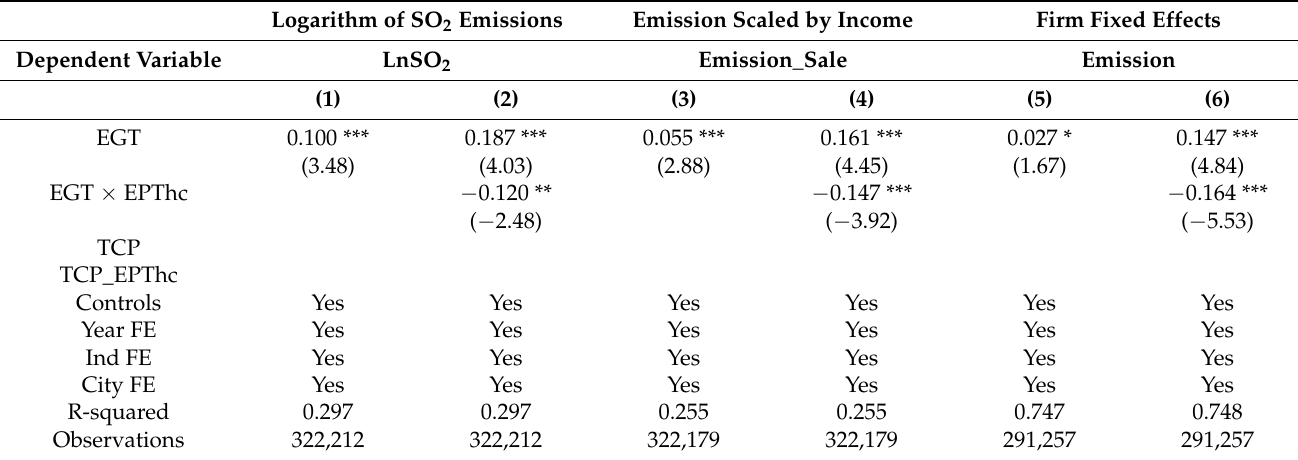
Table 7. Other robustness